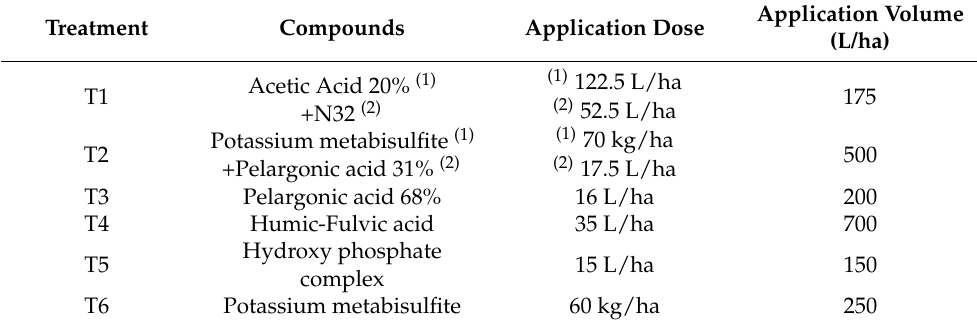
Table 2. Compounds tested, application dose and application